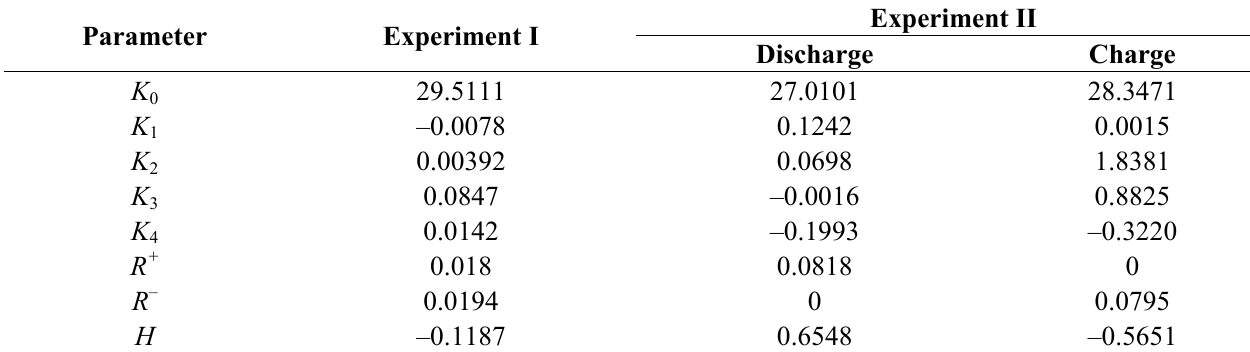
Table 3. Modeling result of battery parameters.